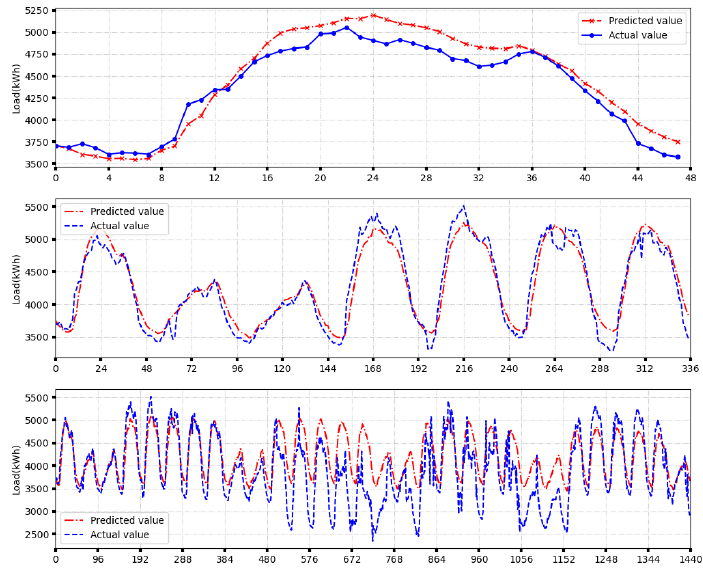
Figure 14. LSTM blind test.